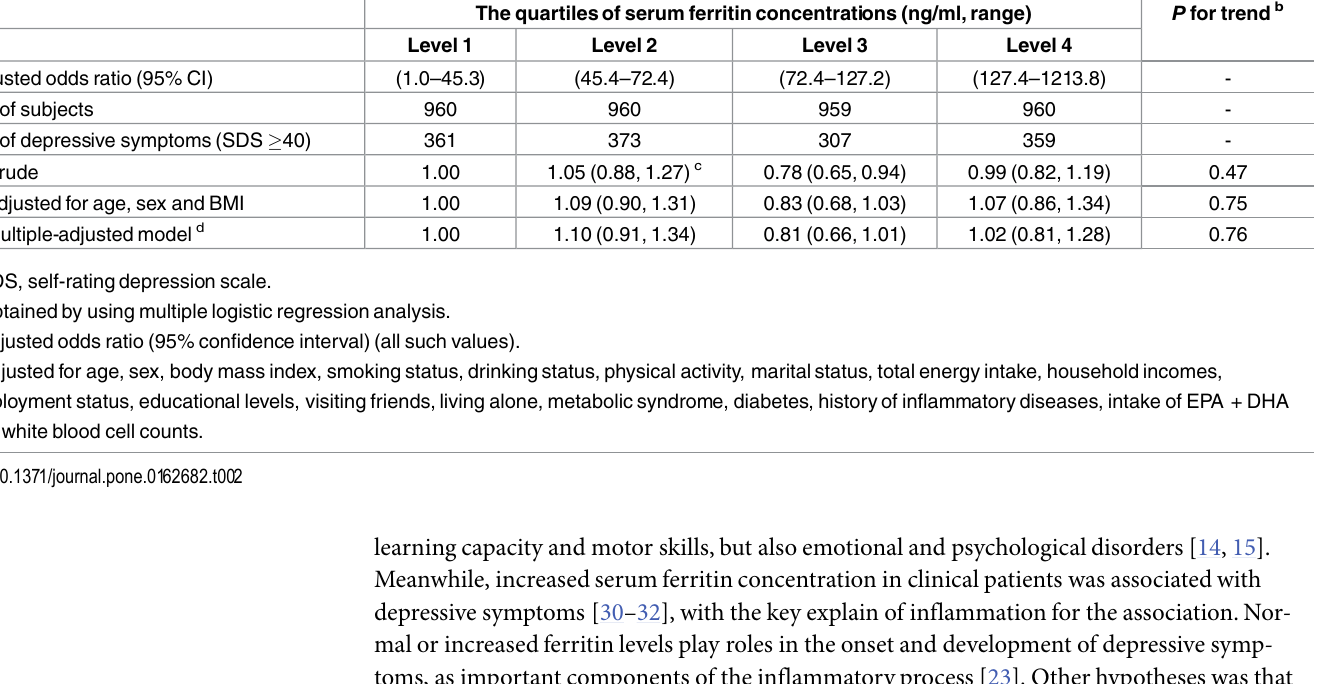
Table 2. The relationships of the quartilesof serum ferritinconcentrationsto depressivesymptoms(n = 3,839) a . The quartilesof serum ferritinconcentrations